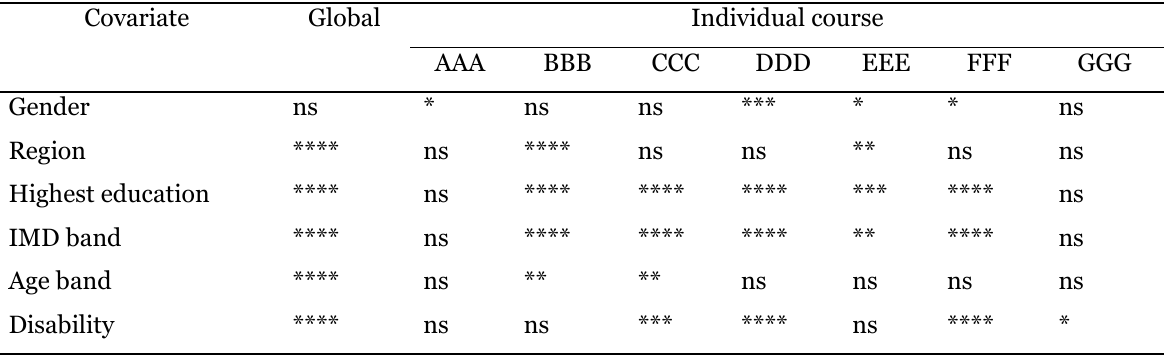
Statistical Significance of Covariates at the Global and Individual Course Levels